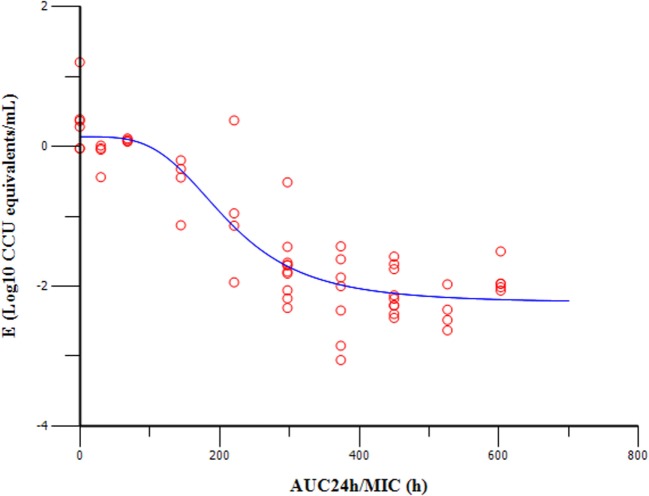
Sigmoid Emax relationships of tiamulin between antimycoplasmal effect (E, log10 ccu equivalents/mL) and in vivo AUC24h/MIC ratio against MG in serum of chickens.